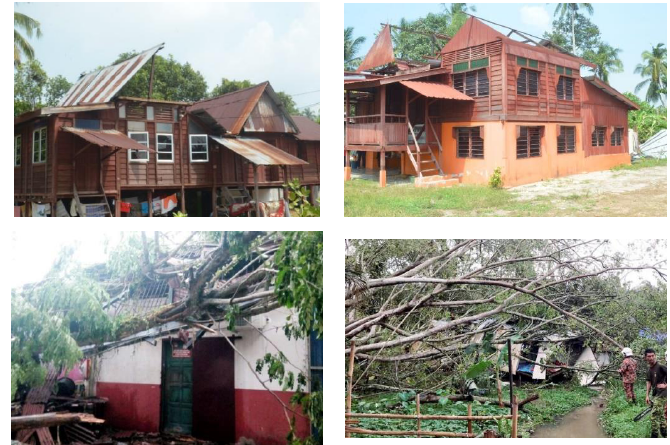
Figure 1. Tropical cyclones damage in rural areas in